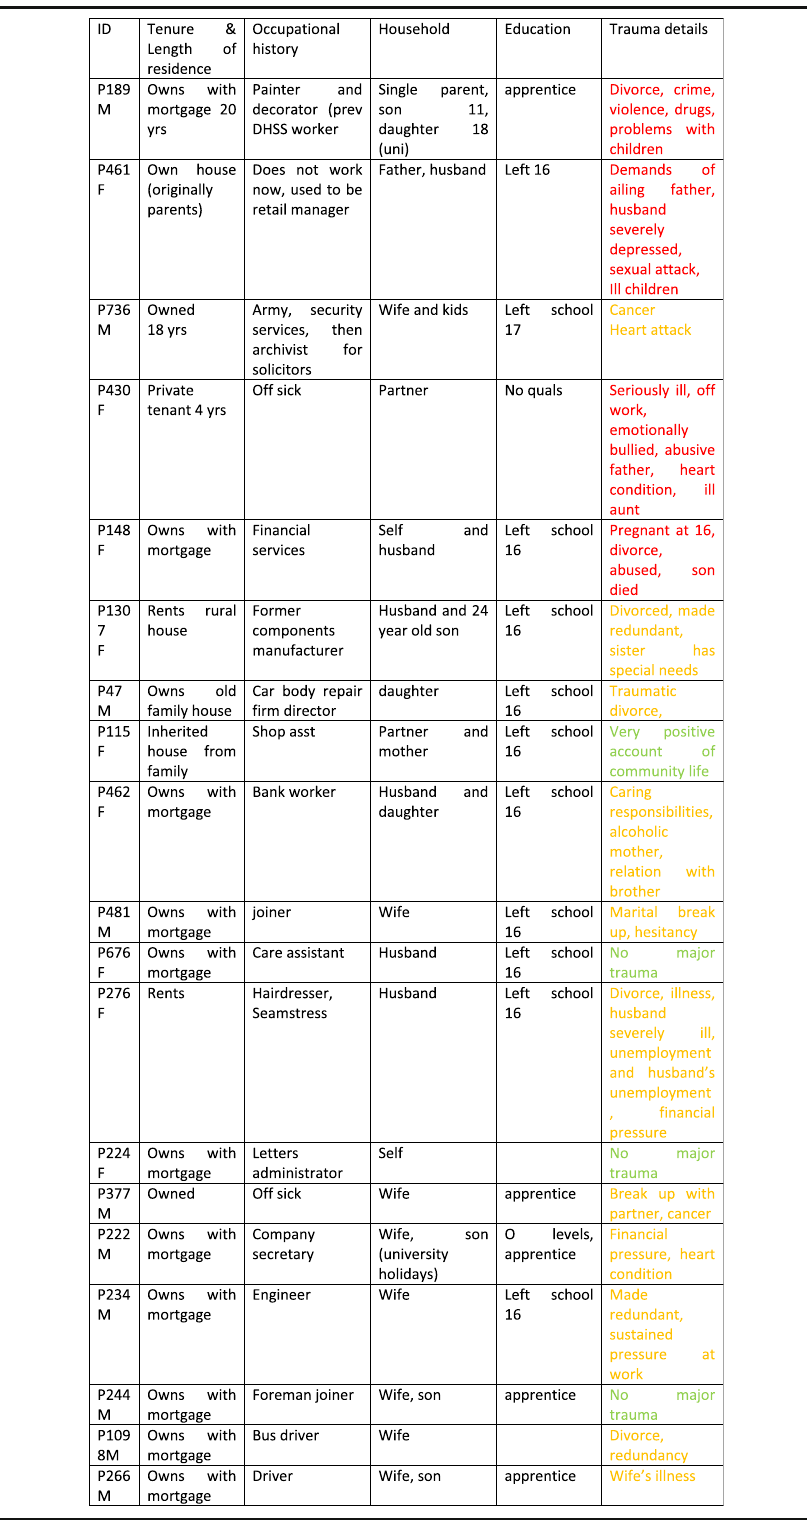
Table 4 Interviews with precariat, indicating key life factors, and extent to which narrative is